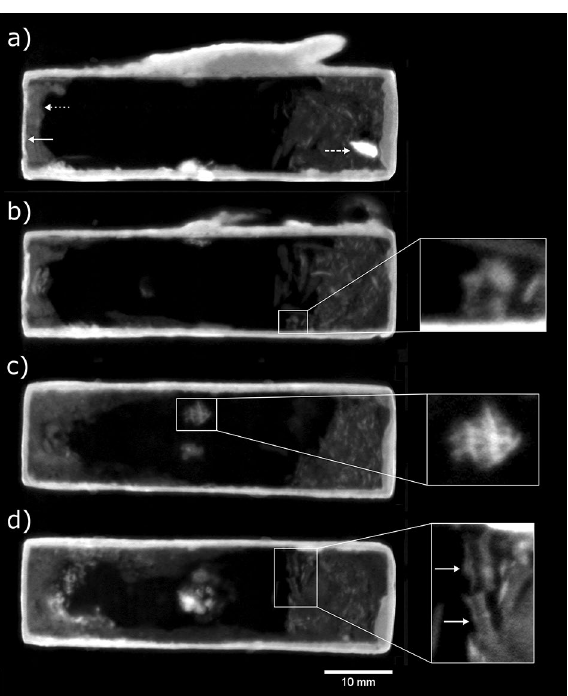
Figure 3. EA49146 multiplanar neutron CT slices, averaged over 0.44 mm slice thickness: ( a ) side-view slice centred 7.0 mm from right side of box (solid arrow: metal plate covering plug, dotted arrow: plug, dashed arrow: loose chaplet); ( b ) side-view slice centred 11.7 mm from right side of box (inset: vertebra, transverse cross- section); ( c ) top-view slice centred 13.8 mm from base of box (inset: textile fragment); ( d ) top-view slice centred 2.1 mm from base of box (inset: vertebrae, longitudinal cross-section, indicated by solid